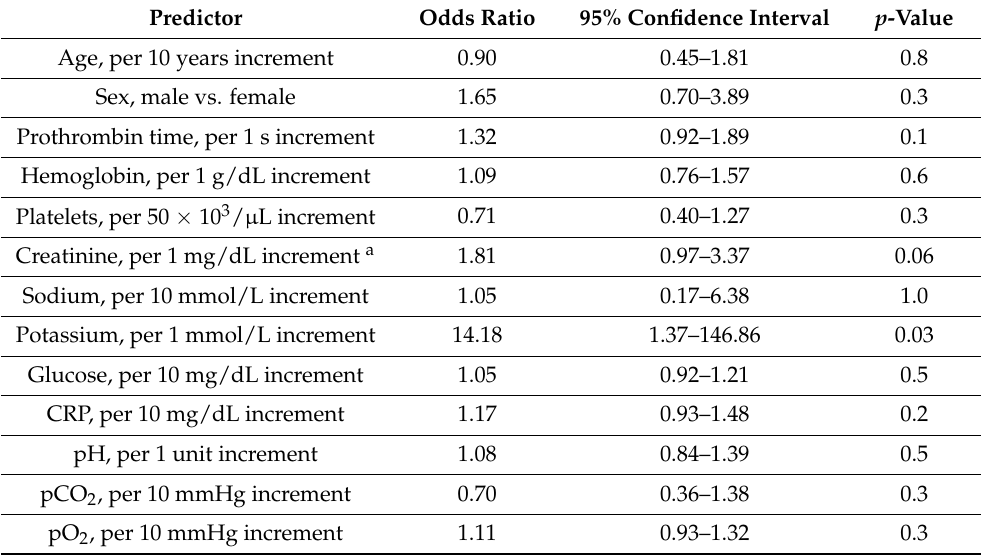
Table 3. Univariate logistic regression analysis of the predictors of survival with laboratory parame- ters as continuous